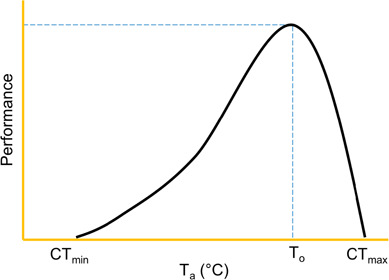
Theoretical thermal performance curve showing the final preferendum (To), critical thermal minimum (CTmin) and CTmax, adapted from Huey and Kingsolver (1993).